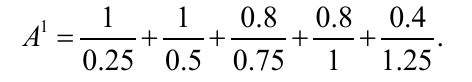
Table 3. System of indicators for assessment